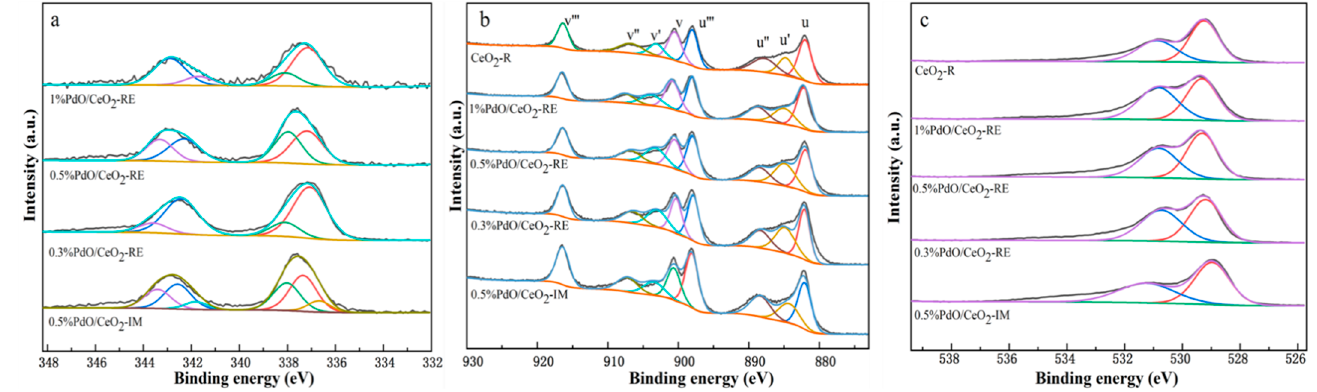
Figure 5. Pd 3d ( a ), Ce 3d ( b ) and O 1s ( c ) XPS spectra of the as-synthesized samples. Table 2. Chemical and structural data of CeO 2 -R and Pd/CeO 2